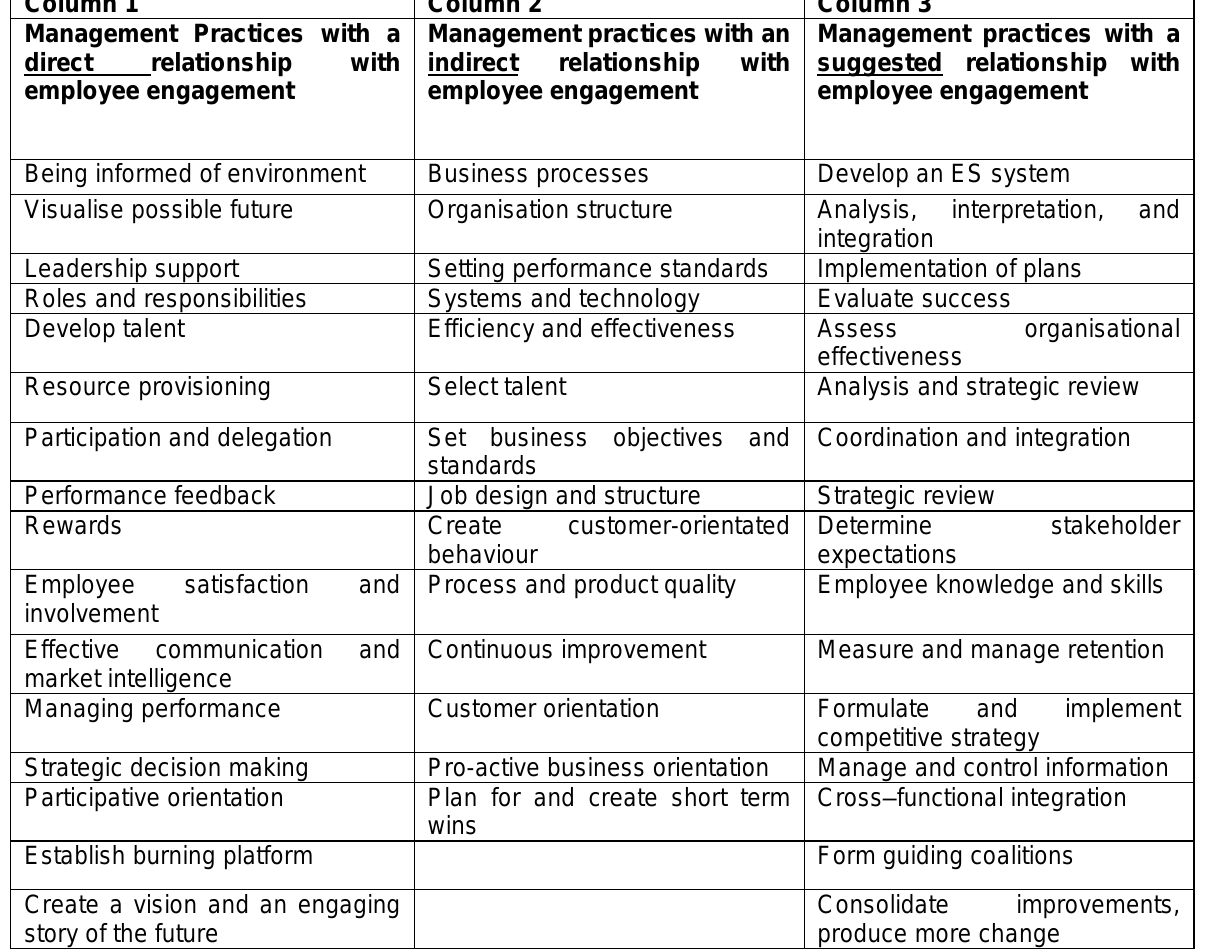
Table 1: Comparison between direct, indirect, and suggested relationships